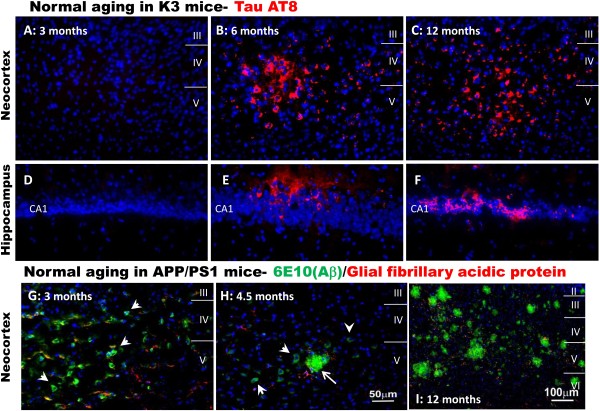
Time course of the natural development of cortical pathology in K3 and APP/PS1 mice. (A), (B), (C), (D), (E), (F) Micrographs of hyperphosphorylated tau labelling (red), using the AT8 antibody, in the neocortex (A to C) and hippocampus (D to F) of untreated K3 mice at 3 months (A, D), 6 months (B, E) and 12 months (C, F) of age. (G), (H), (I) Micrographs of amyloid-beta (Aβ) labelling (green), using the 6E10 antibody, in neocortex of untreated APP/PS1 mice at 3 months (G), 4.5 months (H) and 12 months (I) of age. Arrowheads indicate intraneuronal Aβ labelling, arrows indicate extracellular plaques. Comparable immunolabelling was achieved with the 4G8 antibody. Sections were co-labelled for glial fibrillary acidic protein (red), a marker of astrocytes. For all sections, nuclei were labelled with bisbenzimide (blue). Scale in (H) applies to (A) to (G).